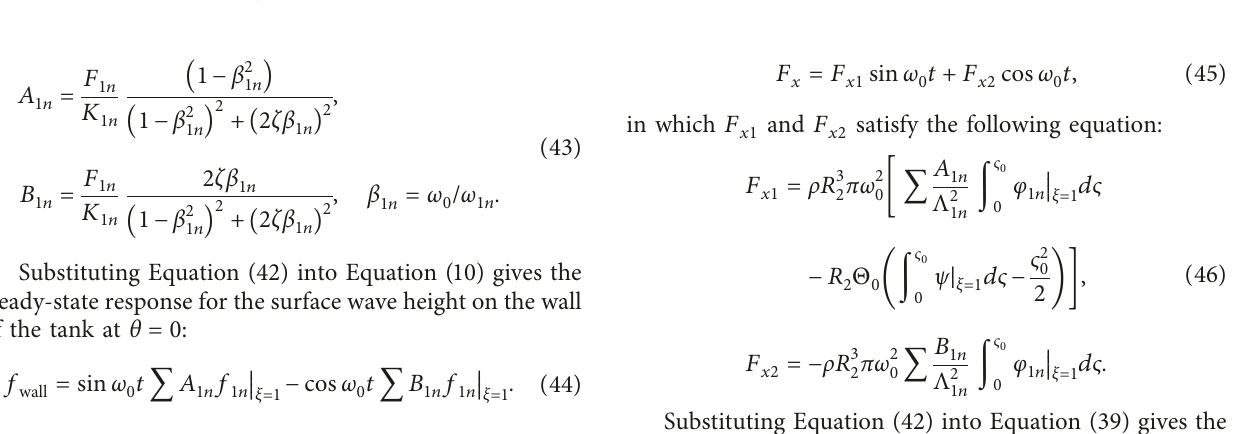
Figure 6: Comparisons of the time histories of the surface wave height on the wall ( θ � 0) among the exact solution, ADINA solution and � present analytical result for ω 0